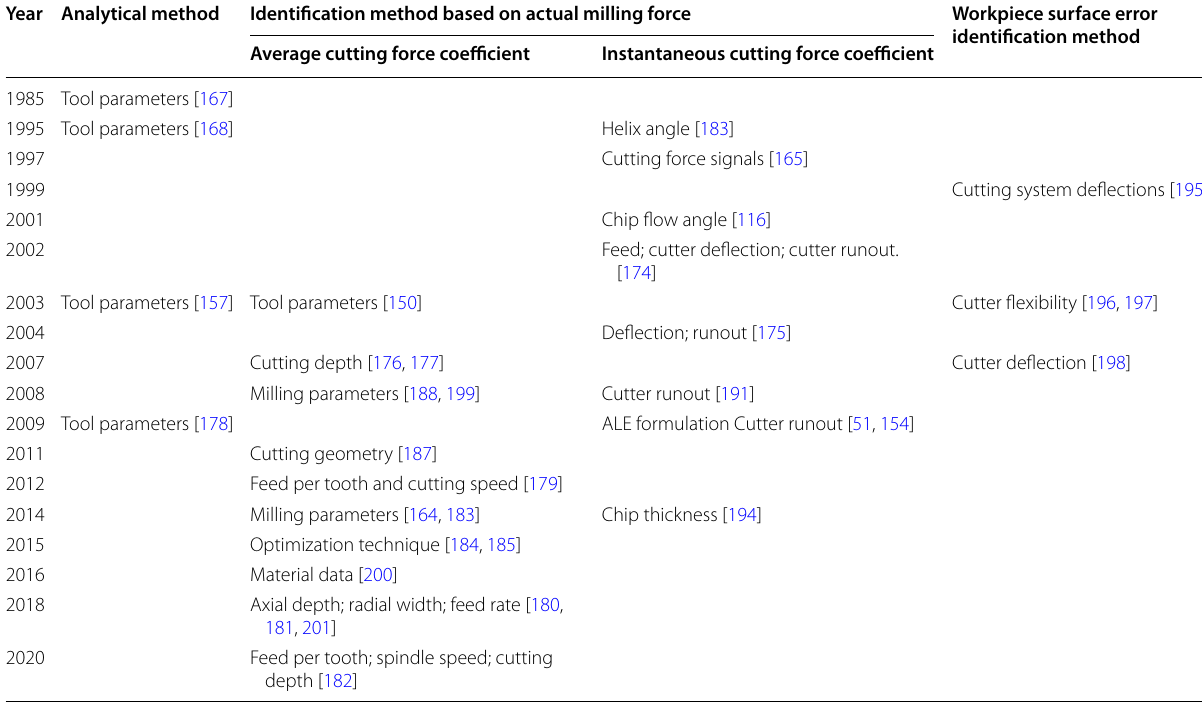
Table 6 Literature on milling force